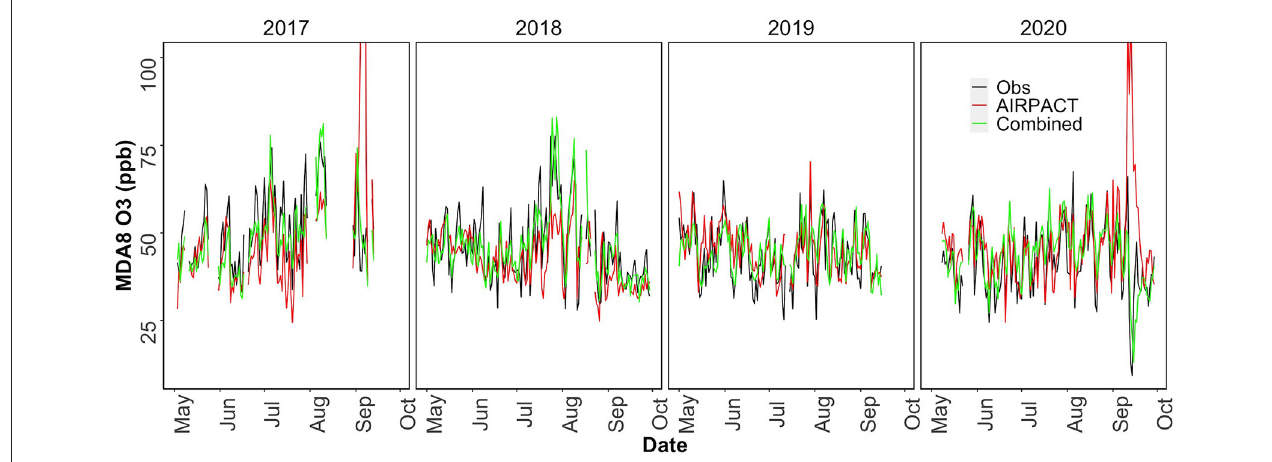
FIGURE 6 | Time series of MDA8 O 3 from observation, AIRPACT and combined ML model predictions from May to September in 2017–2020.